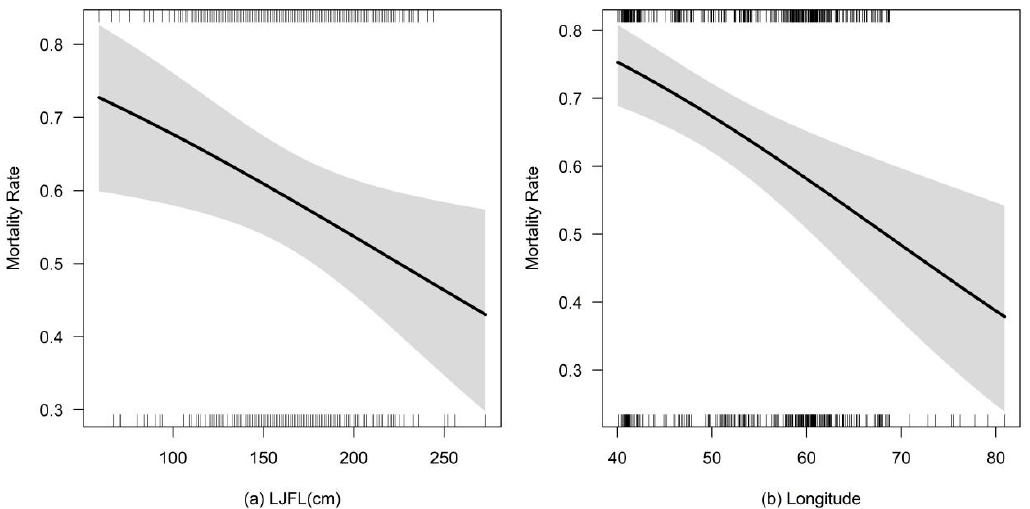
Figure 4. Effects of Lower Jaw-Fork Length (LJFL) variation ( a ) and longitude variation ( b ) on at- haulback mortality in Indian Ocean swordfish. The solid line represents the change in the predicted mortality with LJFL and longitude, and the gray shaded part represents the 95% confidence interval of the explanatory variable. The short lines at the top and bottom of the picture indicate the number of samples that died and survived at a certain longitude.